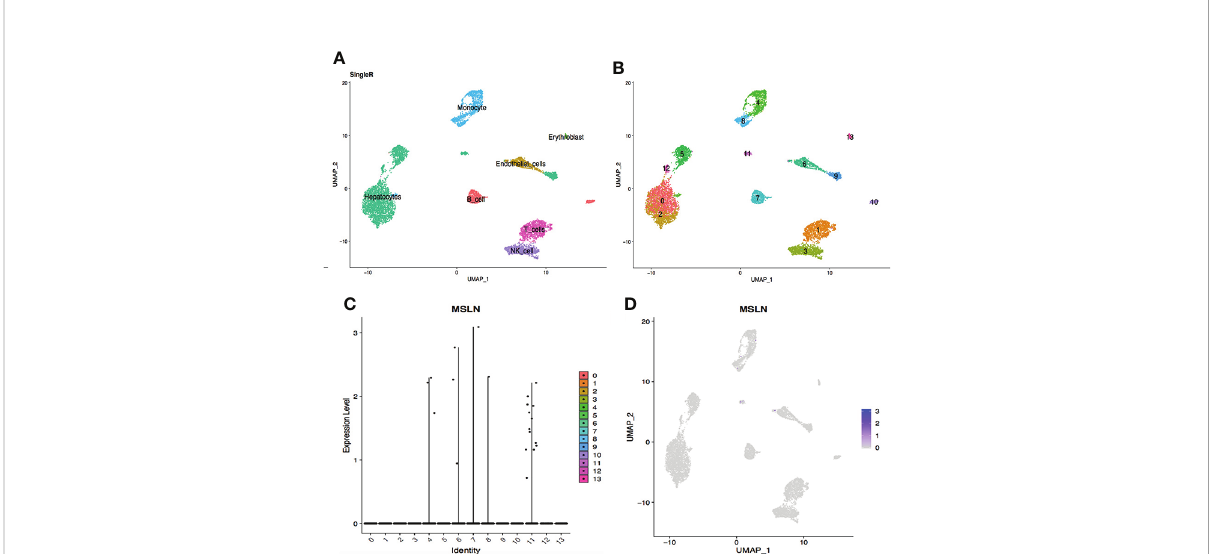
FIGURE 6 scRNA-seq data analysis of hepatic cells showing low MSLN expression. (A) Cell types in the liver according to SingleR. (B) Cells in the liver were categorized into 14 different clusters, numberedd 0 to 13. (C) Violin plot of MSLN expression distribution in these 14 different cell clusters. (D) The MSLN expression distribution shown as a scatter